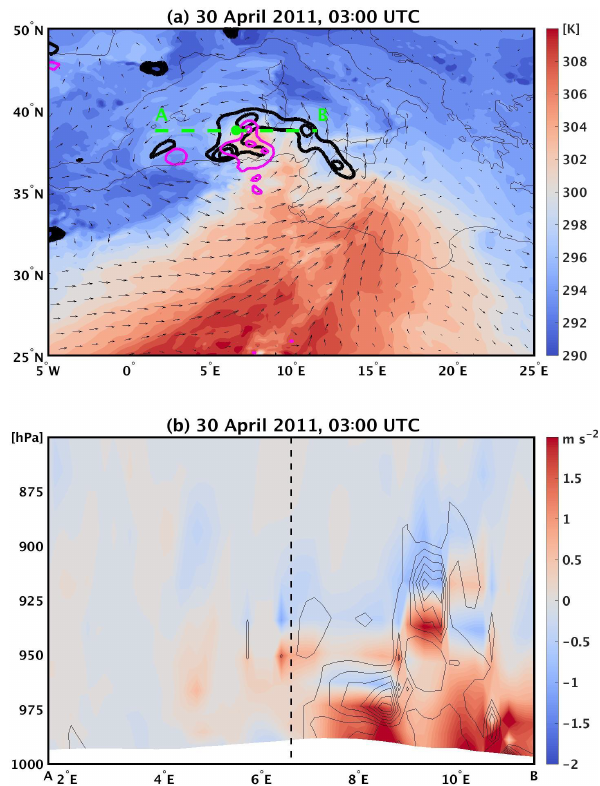
Figure 17. (a) Fields of θ (in colour), wind (arrows), q mo (in black contours with 0.5PVU contour intervals, starting from 1PVU) and q mo1 (in magenta contours for − 0 . 5 and − 1PVU) at 850hPa at the time of the mature stage of cyclone no. 62. (b) Vertical cross section along the green line of panel (a) , showing in colours the field of F x (momentum forcing from PBL parameterisation) and in black contours the field of baroclinic PV production (sum of two last terms in Eq. 8), starting from 0.05PVUs − 1 with an interval of 0.1PVUs − 1